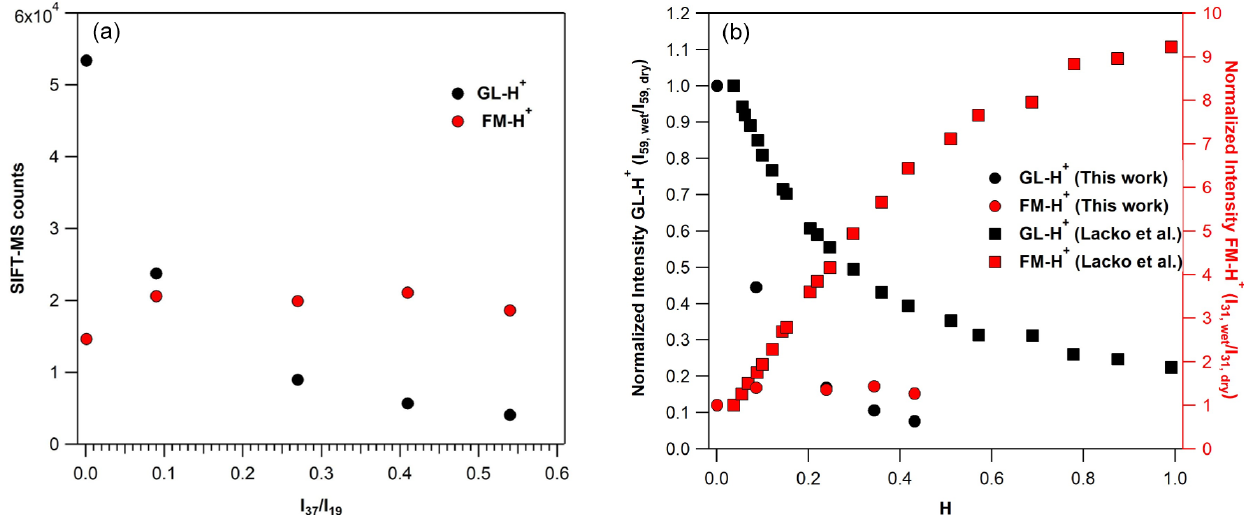
Figure 6. (a) SIFT-MS counts at the mass peak of 59 (in black) of GL-H + and the mass peak of 31 (in red) of FM-H + , recorded by SIFT-MS under SC conditions, using around 750ppb of GL operating the instrument under SCs. (b) Normalized sensitivity at the mass peak of 59 (in black) of GL-H + and the mass peak of 31 (in red) of FM-H + recorded with SIFT-MS under SCs, based on the results of the current study (circles) and Lacko et al. (2020; squares; data extracted from their Fig. 3) versus the H value Eq.